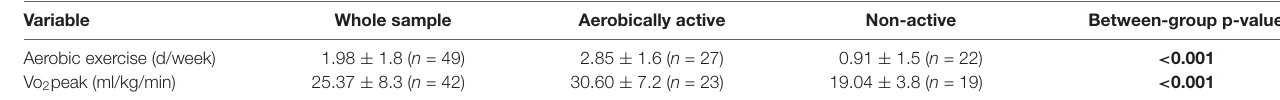
TABLE 2 | Aerobic activity and fitness characteristics of the participants (means ± SD). Variable Whole